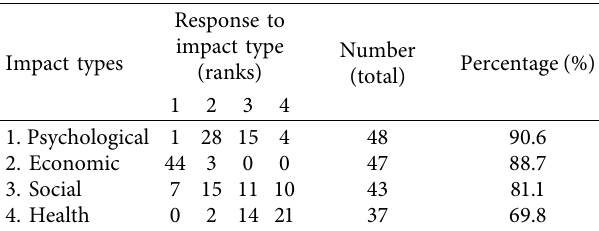
Table 10: Types of human-wild animals’ conflict impact